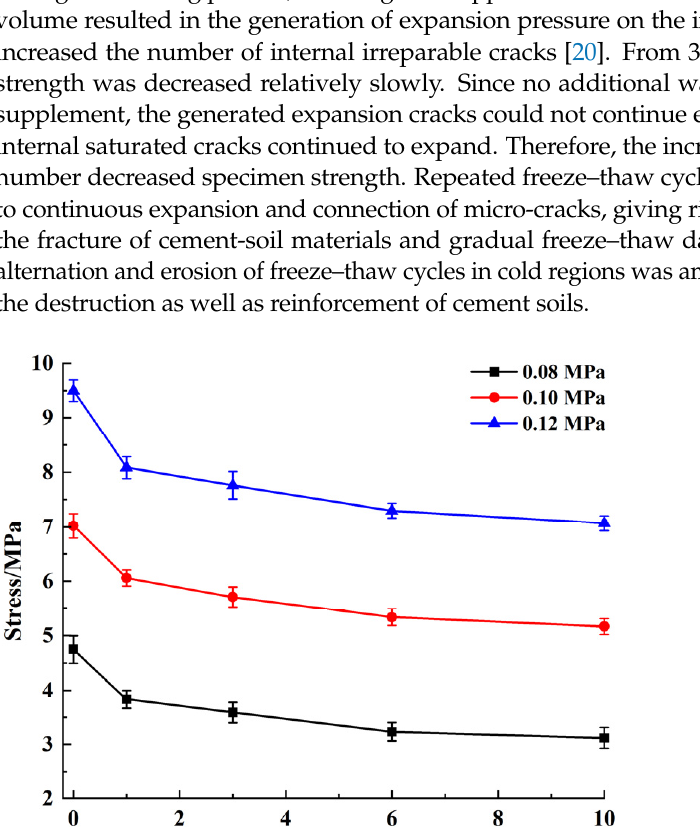
Figure 6. Effect of freeze–thaw cycles on sample strength. Freeze–thaw cycles significantly affect the strength of cement soils. With the increase of freeze–thaw cycle number, the strength of the cement soil gradually decreases. When there was no water supplement during the melting process, the strength reduction rate of the sample was gradually decreased, as shown in Figure 7. However, if the water was